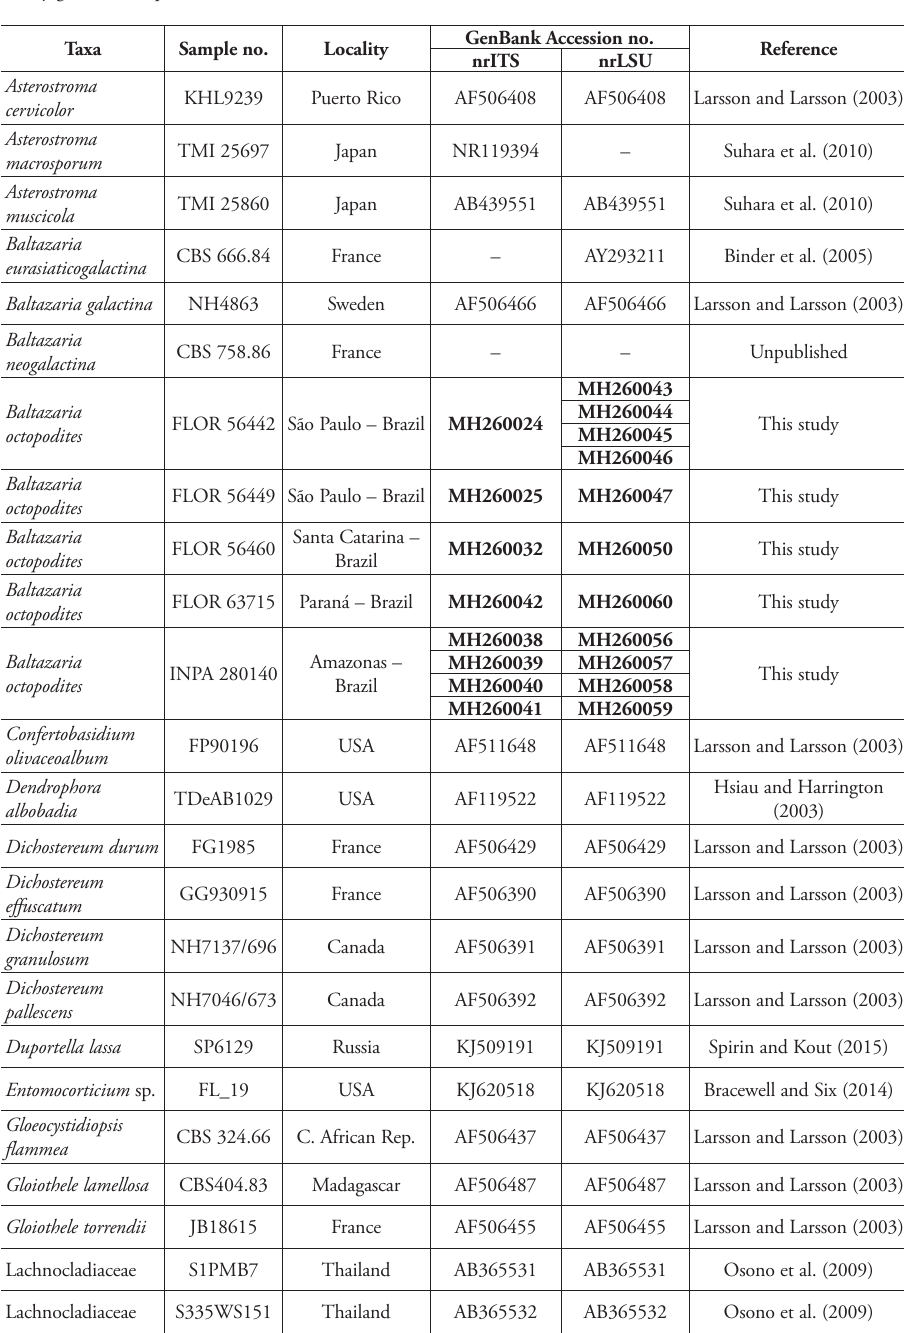
Table 1. Species from clade /peniophorales and their GenBank accession numbers of ITS and nrLSU sequences. Newly generated sequences are shown in